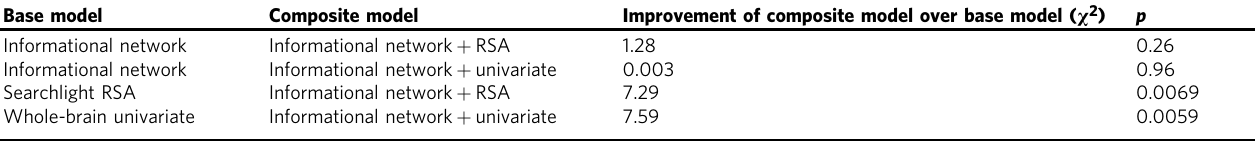
Table. 3 Direct model comparisons between neural scores Base